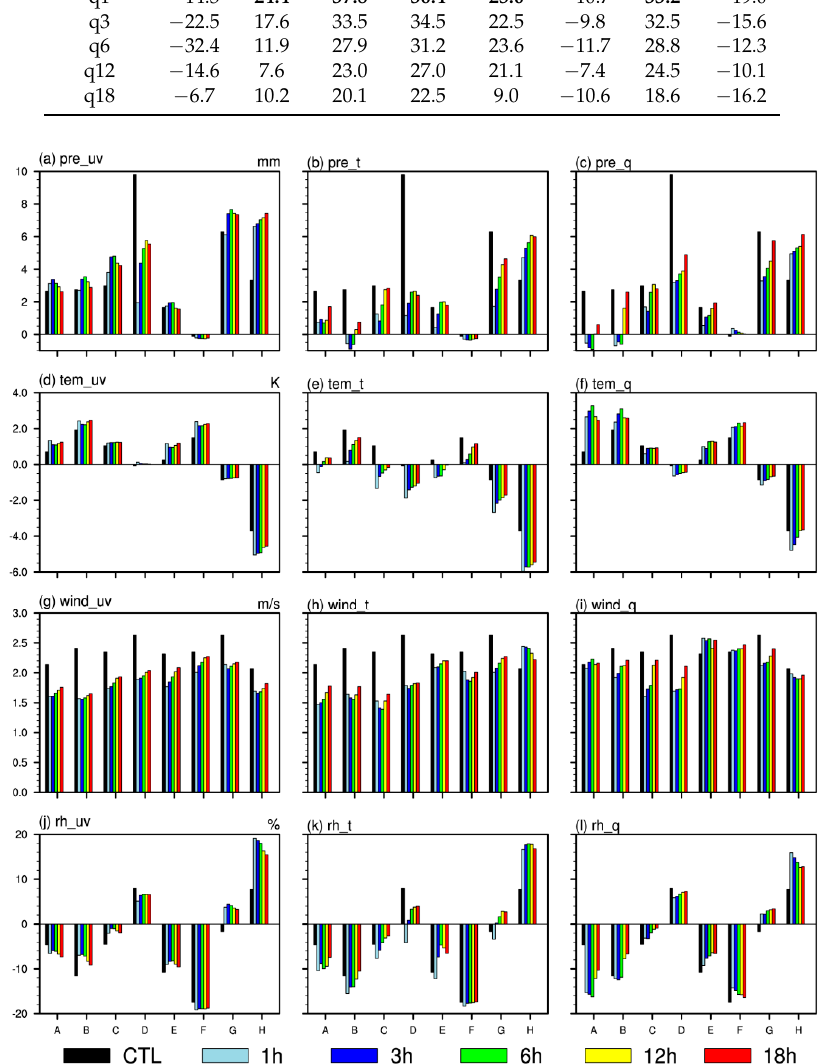
Figure 4. Mean error (ME) of simulated near-surface meteorological elements with different nudging time: simulated precipitation ( a – c ); temperature ( d – f ); wind speed ( g – i ); and relative humidity ( j – l ), which are derived from: nudging uv ( a , d , g , j ); nudging θ ( b , e , h , k ); and nudging q ( c , f , i , l ). Different schemes were also compared in the correlation of near-surface meteorological elements between simulations and observations. Figure 5 shows the CC about precipitation. For CTL, except in Northeast (A) and West of Northwest (F), the simulated precipitation failed in the significance test at 0.1% significance level. With the presence of nudging, the CC was extremely raised and passed the significance test in each sub-region. A comparison of the different nudging schemes showed that, when uv was nudged, nudging time of 1 h and 3 h had the best performance; when θ was nudged, nudging time of 3 h improved the CC the most except in East of Northwest (E) and Southwest (G); and, when q was nudged, nudging time of 1 h had the best result in almost all areas. It was noted that the CC was slightly poorer in West of Northwest (F) and Tibet (H), than that in other sub-regions. The CC of other near-surface meteorological elements showed similar conclusion. Except for the simulated wind speed when q was nudged in North China (B) and East China (C), the simulation results of all other nudging experiments passed the significance test at a 0.1% significance level.